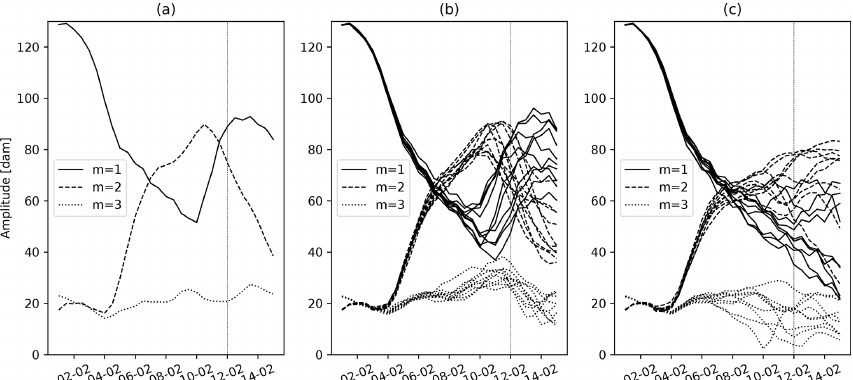
Figure 4. Time series of amplitudes of planetary waves with wavenumbers m = 1, 2 and 3 in geopotential height (dam) at 10hPa averaged over the latitudinal belt 40–75 ◦ N (a) ERA-I reanalysis, (b) ENS + members, (c) ENS − members. Vertical line denotes the SSW2018 central